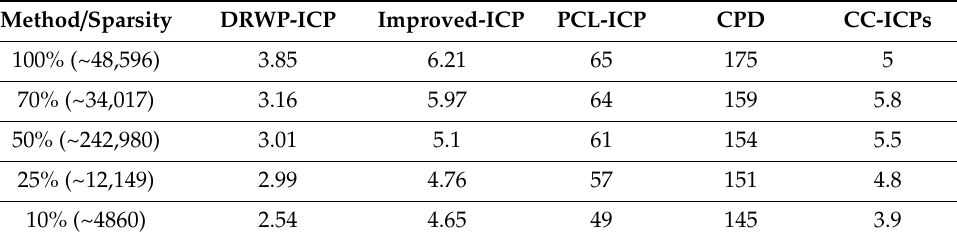
Table 9. Alignment times (seconds).